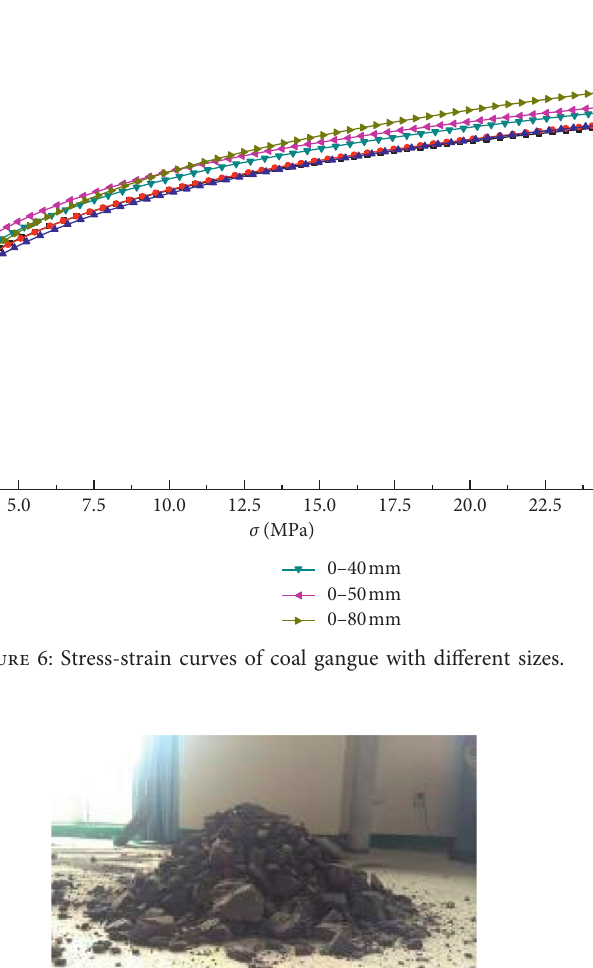
Figure 5: Depth of mining and the rate of subsidy affect the subsidence. (a) Surface subsidence. (b) Surface horizontal